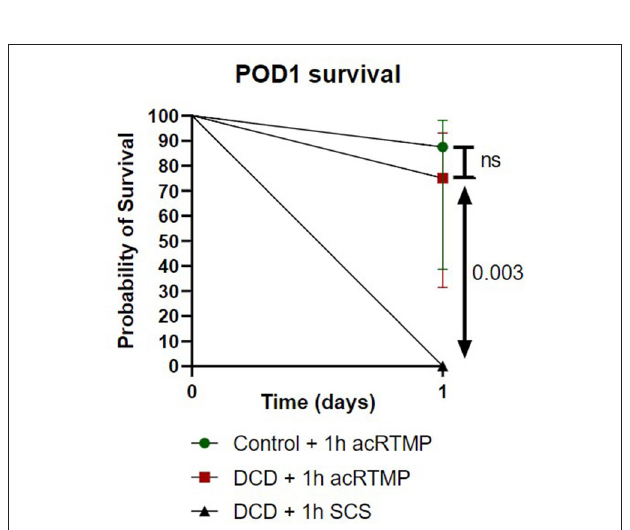
FIGURE 7 | Liver transplant survival to study